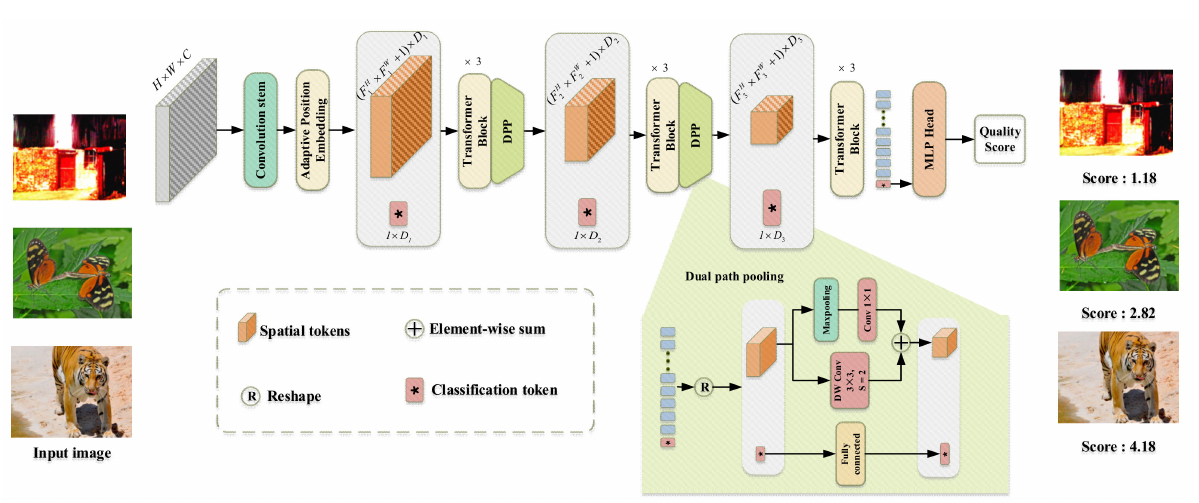
Figure 5. The overview of the network architecture of the proposed